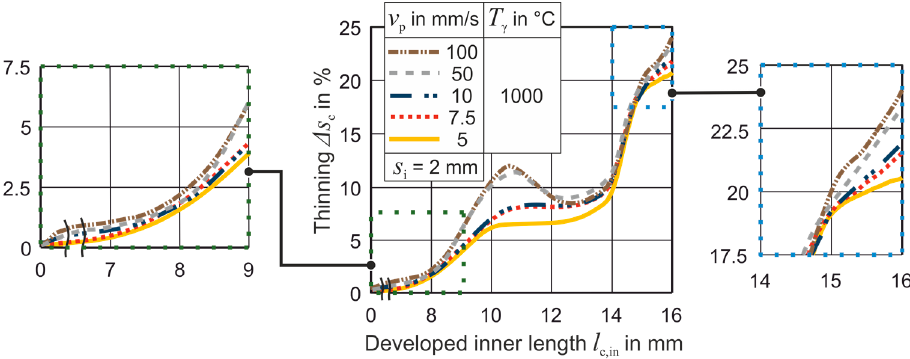
Figure 7. Effect of the punch speed v p on thinning of collar ∆ s c for a constant austenitizing temperature T γ of 1000 ◦